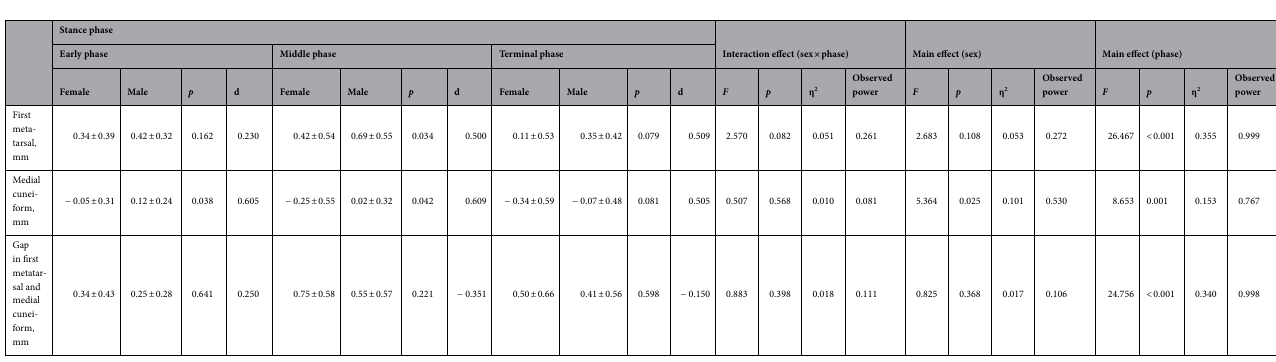
Table 3. Differences in the first metatarsal, medial cuneiform, and gap during stance phase. Data are shown as mean ± standard deviation. d Cohen’s d, η 2 partial eta-squared. Significant effect of participant sex on the vertical location of the medial cuneiform were found. Significant effects of gait phase on the vertical locations of the first metatarsal, medial cuneiform, and the gap between them were